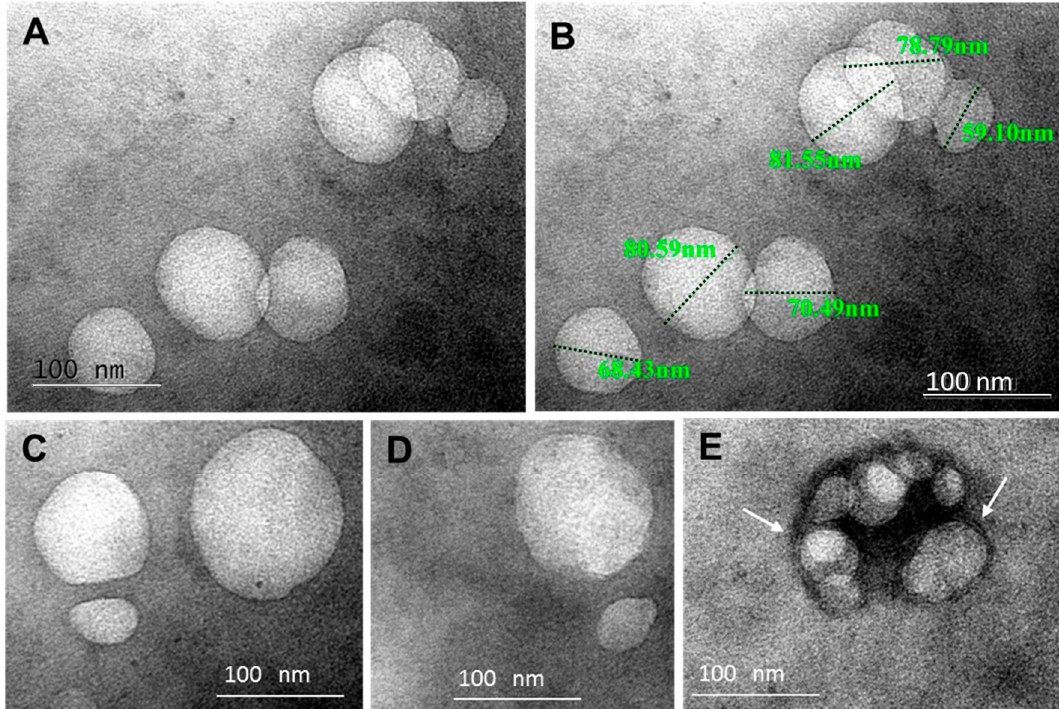
Figure 1. Transmission electron microscopy (TEM) analysis of a crude small extracellular vesicle (EV) pellet from one early ARDS patient’s BAL fluid by the whole mount method. The 120,000 g pellet of the 40,000 g supernatant was fixed with 4% paraformaldehyde and stained with 2% OsO 4 . The majority of the individual EVs were less than 100 nm ( A , B ), although EVs of 120–140 nm ( C , D ) and multivesicular bodies of small EVs (25–60 nm) enclosed by a lipid bilayer (arrows in E ) were also detected. The pictures are representative of 9 different BAL fluid isolations.